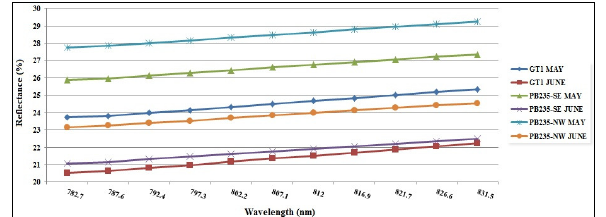
Figura 12. Spectral behaviour in canopy scale, for May and June, in the region of 800nm of Rubber trees stands: GT1, PB235-SE and PB235-NW